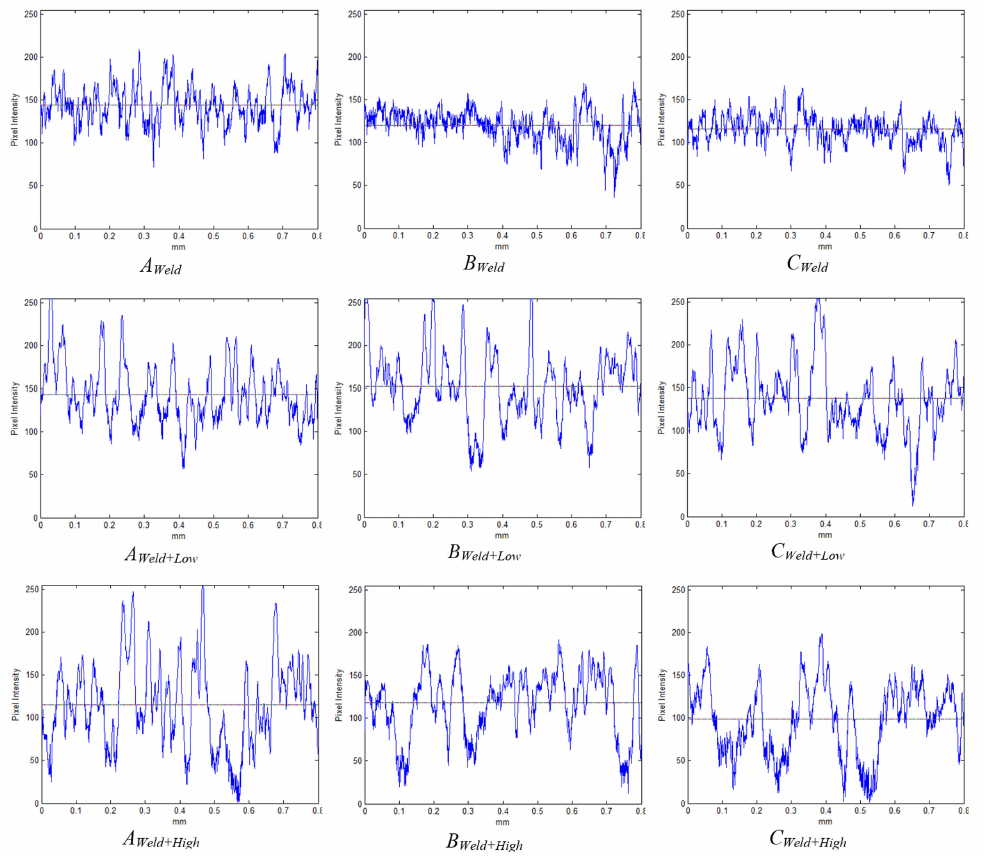
Figure 12. Line profile (center row) for three samples with three regions each. Length = 0.8 mm. Intensity is 0 for black and 255 for white